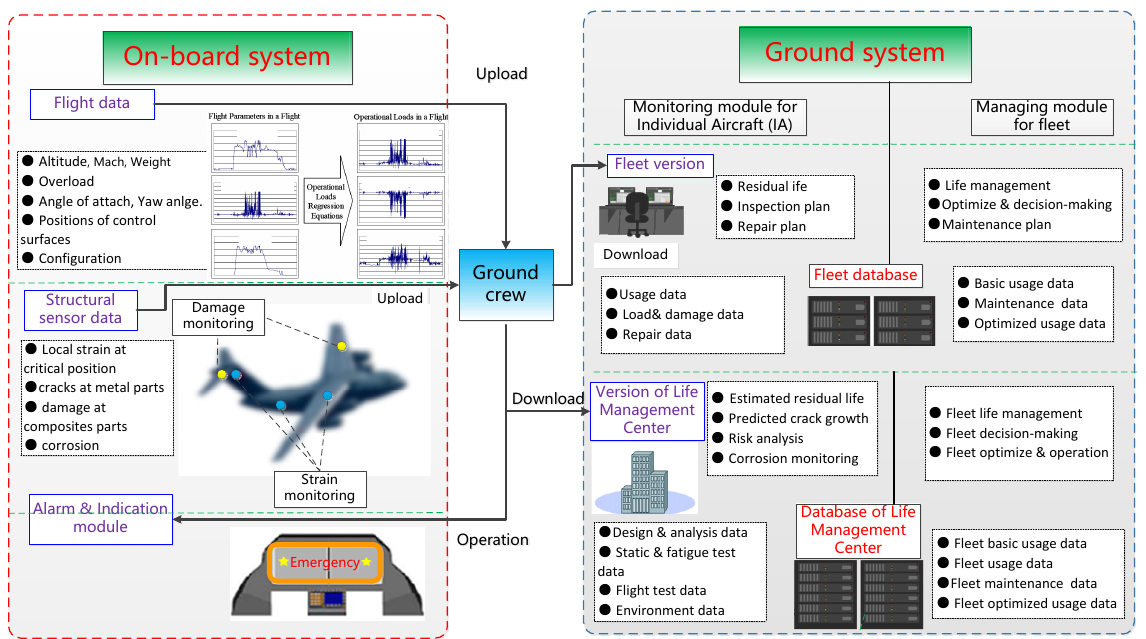
Figure 12. Schematic diagram of structural health monitoring system.